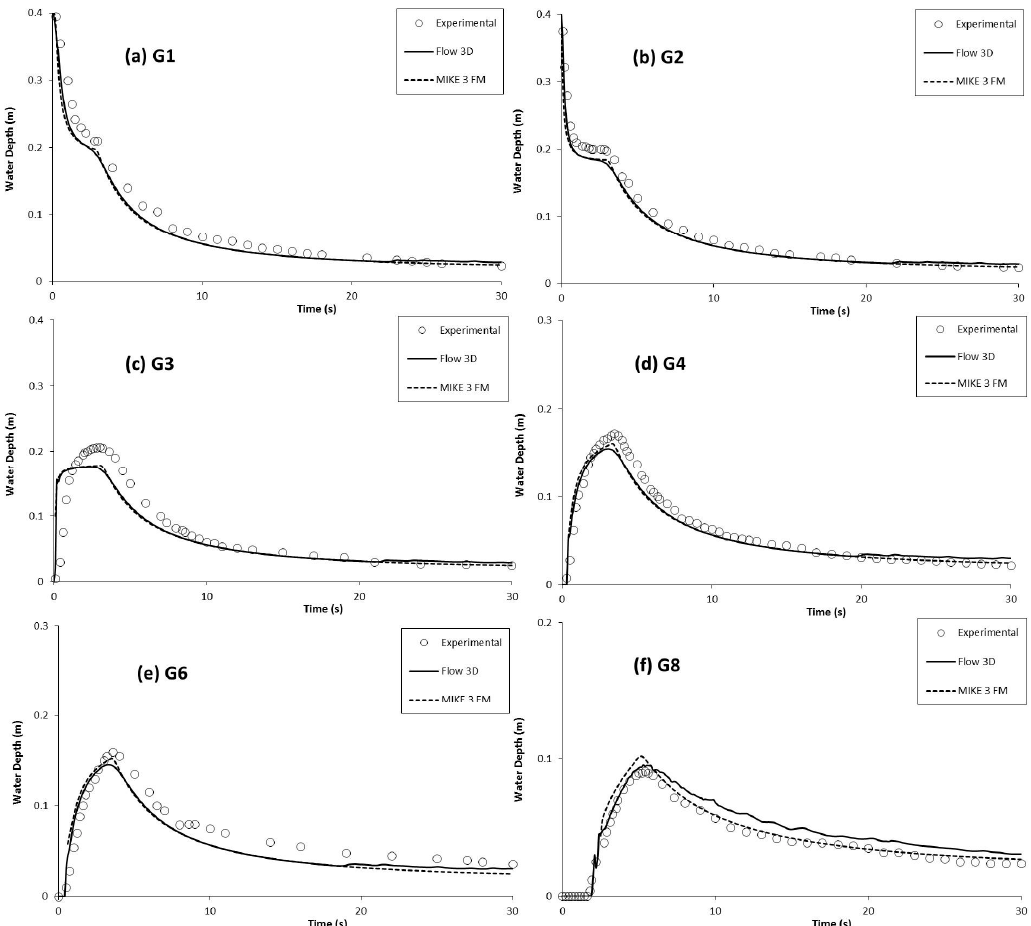
Figure 10. Measured and computed water level hydrograph at various positions for dry ‐ bed by Khankandi et al. [39]: ( a ) G1 ( − 0.5 m); ( b ) G2 ( − 0.1 m); ( c ) G3 (0.1 m); ( d ) G4 (0.8 m); ( e ) G6 (1.2 m); ( f ) G8 (5.5